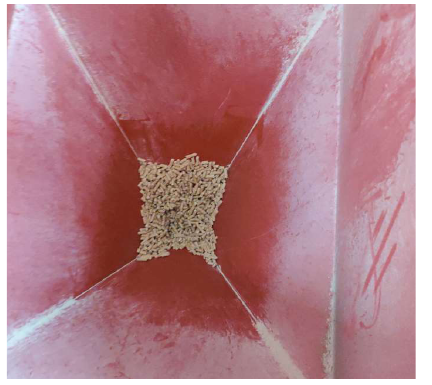
Figure 6. Wood pellets C.